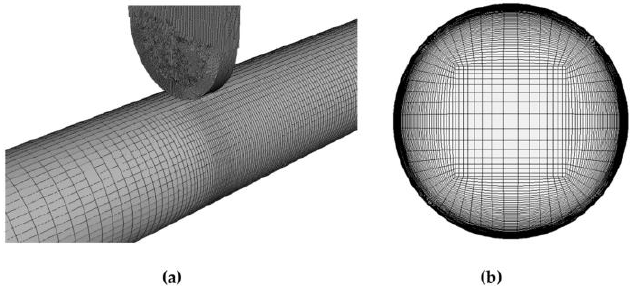
Figure 6. Immersed solid method grid: ( a ) fine grid near the gate; ( b ) grid at the pipe cross-section.